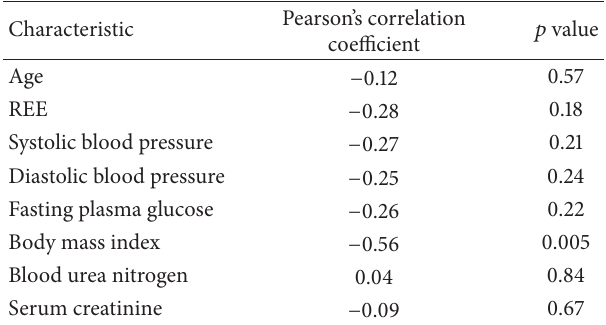
Table 4: Correlation between clinical and biological characteristics and fat-free mass adjusted insulin sensitivity.